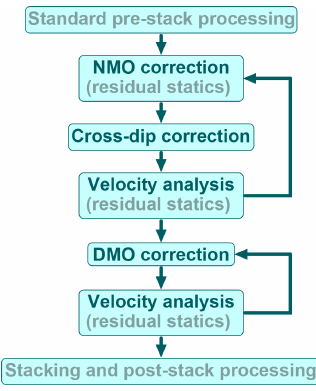
Figure 9. Illustration of the iterative processing scheme for the im- plementation of the cross-dip and DMO corrections. The repetition of the residual static correction after each velocity reanalysis is op-